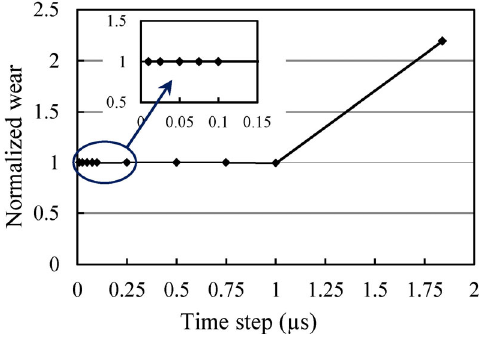
Fig. 2 Sensitivity analysis versus the time step.